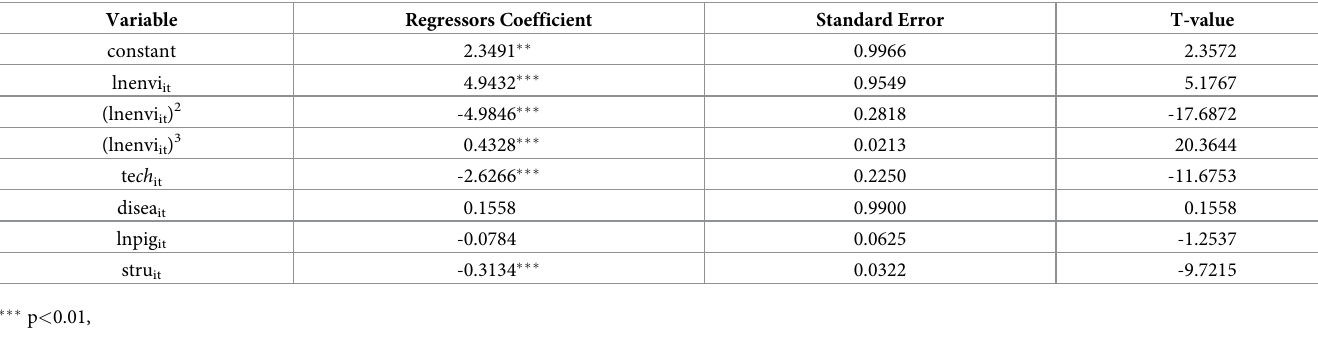
Table 11. The estimation results of influencing factors of cost inefficiency model for